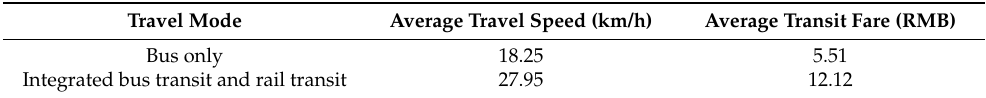
Table 1. A comparison of the average travel speed and average transit fare in the bus-only and rail transit and bus scenarios.